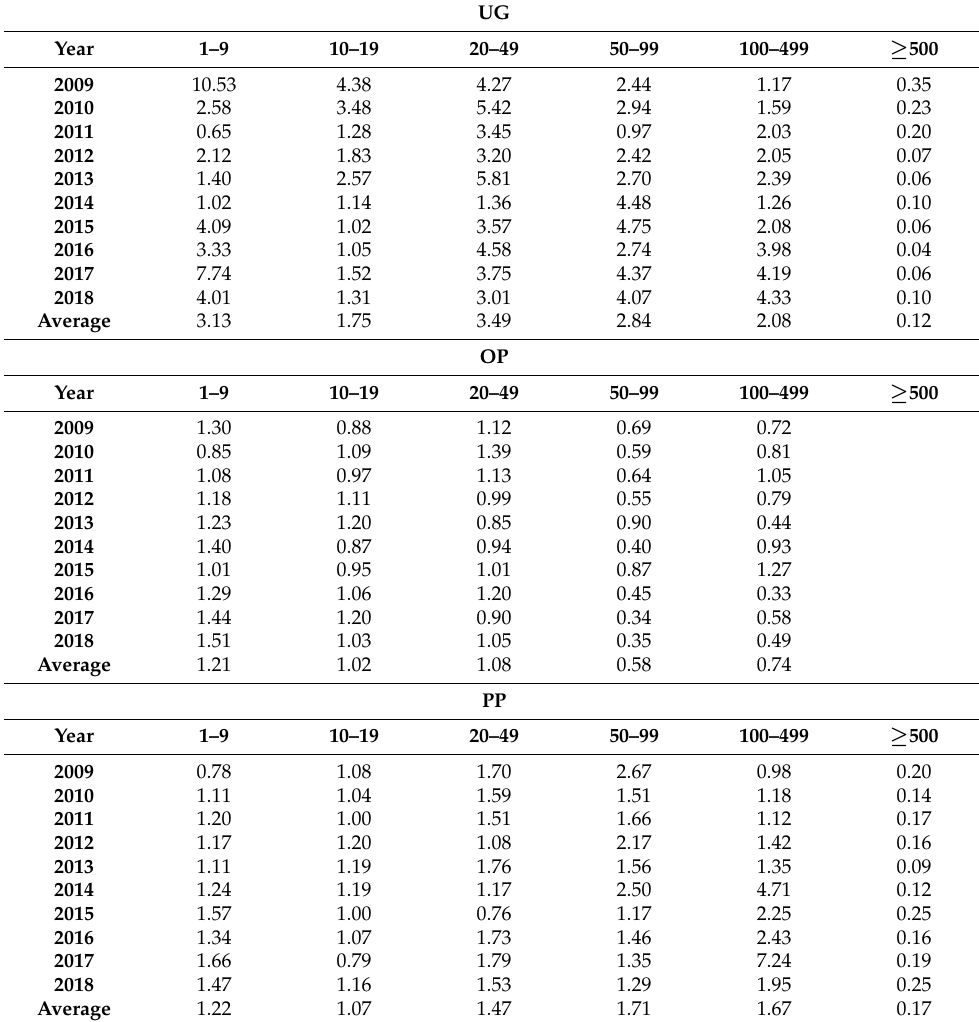
Table 11. Severity risk index per size and each